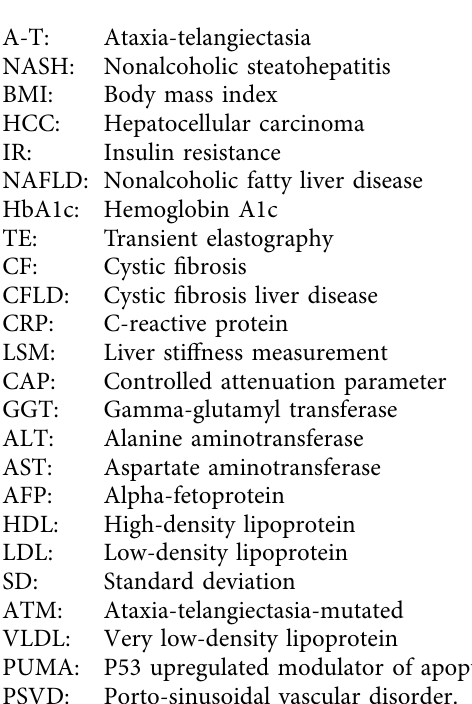
Supplementary Table 1: an overview of the distribution of fbrosis and steatosis stages detected by TE. Supplementary Table 2: the distribution of the stage of liver involvement measured by ActiTest, SteatoTest, and FibroTest. ( Supple- mentary Materials